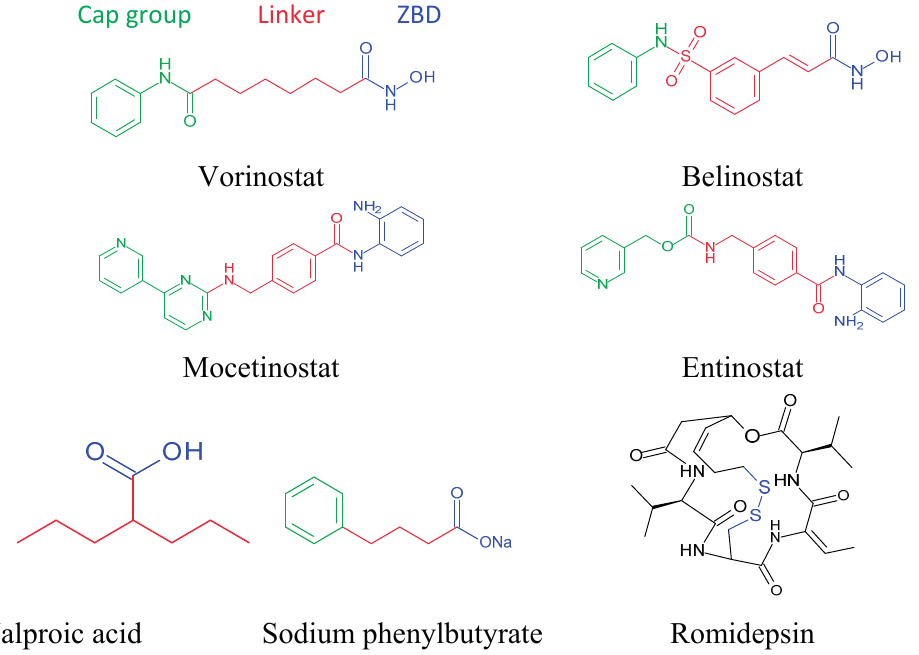
Figure 3. Structure of representative HDAC inhibitors and their pharmacophores. The cap group, linker and the zinc binding domain (ZBD) are colored green, red and blue,